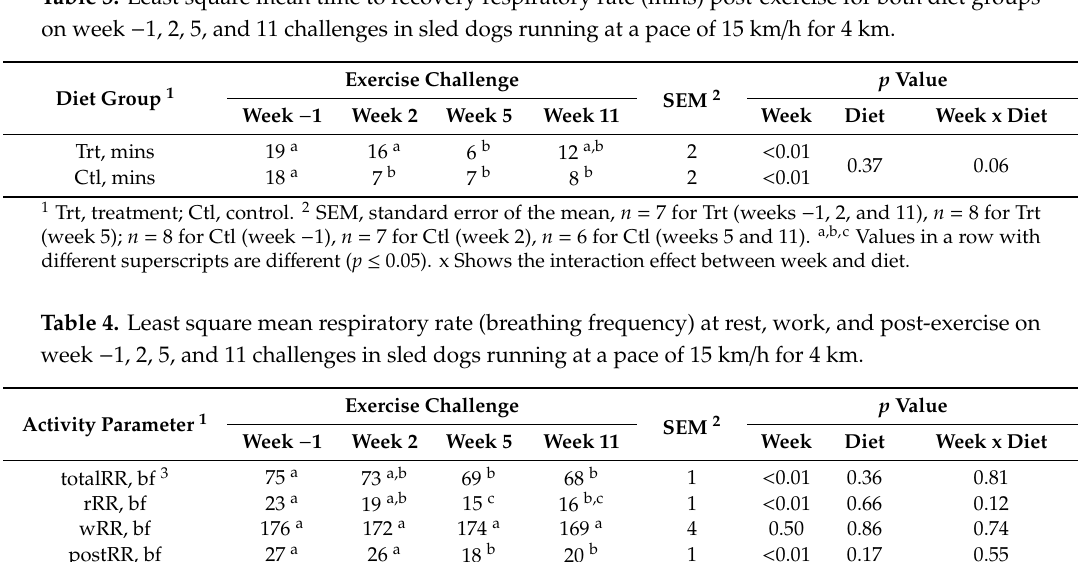
Table 3. Least square mean time to recovery respiratory rate (mins) post-exercise for both diet groups on week − 1, 2, 5, and 11 challenges in sled dogs running at a pace of 15 km / h for 4 km. p Value Exercise Challenge Diet Group 1 SEM 2 Week − 1 Week 2 Week 5 Week 11 Week Diet Week x Diet Trt, mins 19 a 16 a 6 b 12 a,b 2 < 0.01 0.37 0.06 Ctl, mins 18 a 7 b 7 b 8 b 2 < 0.01